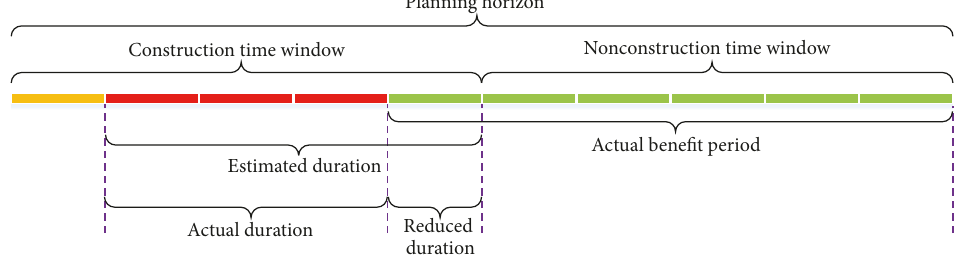
Figure 1: An example of the timeline of a road expansion